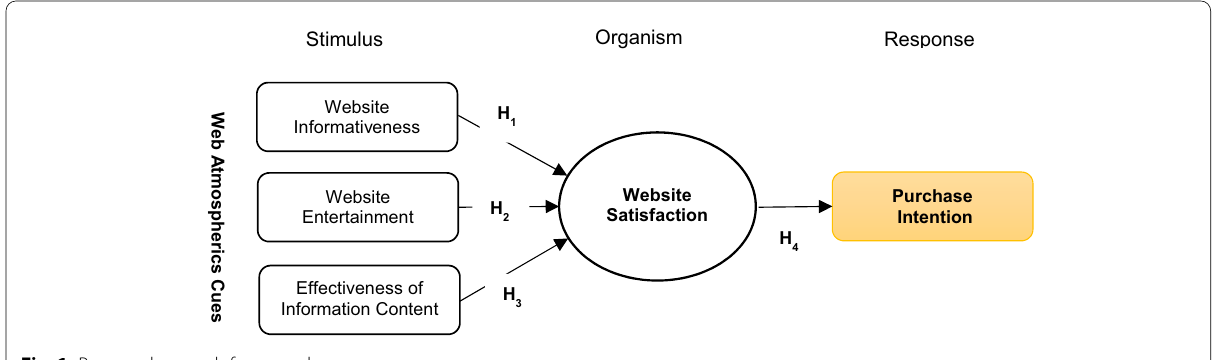
Fig. 1 Proposed research framework